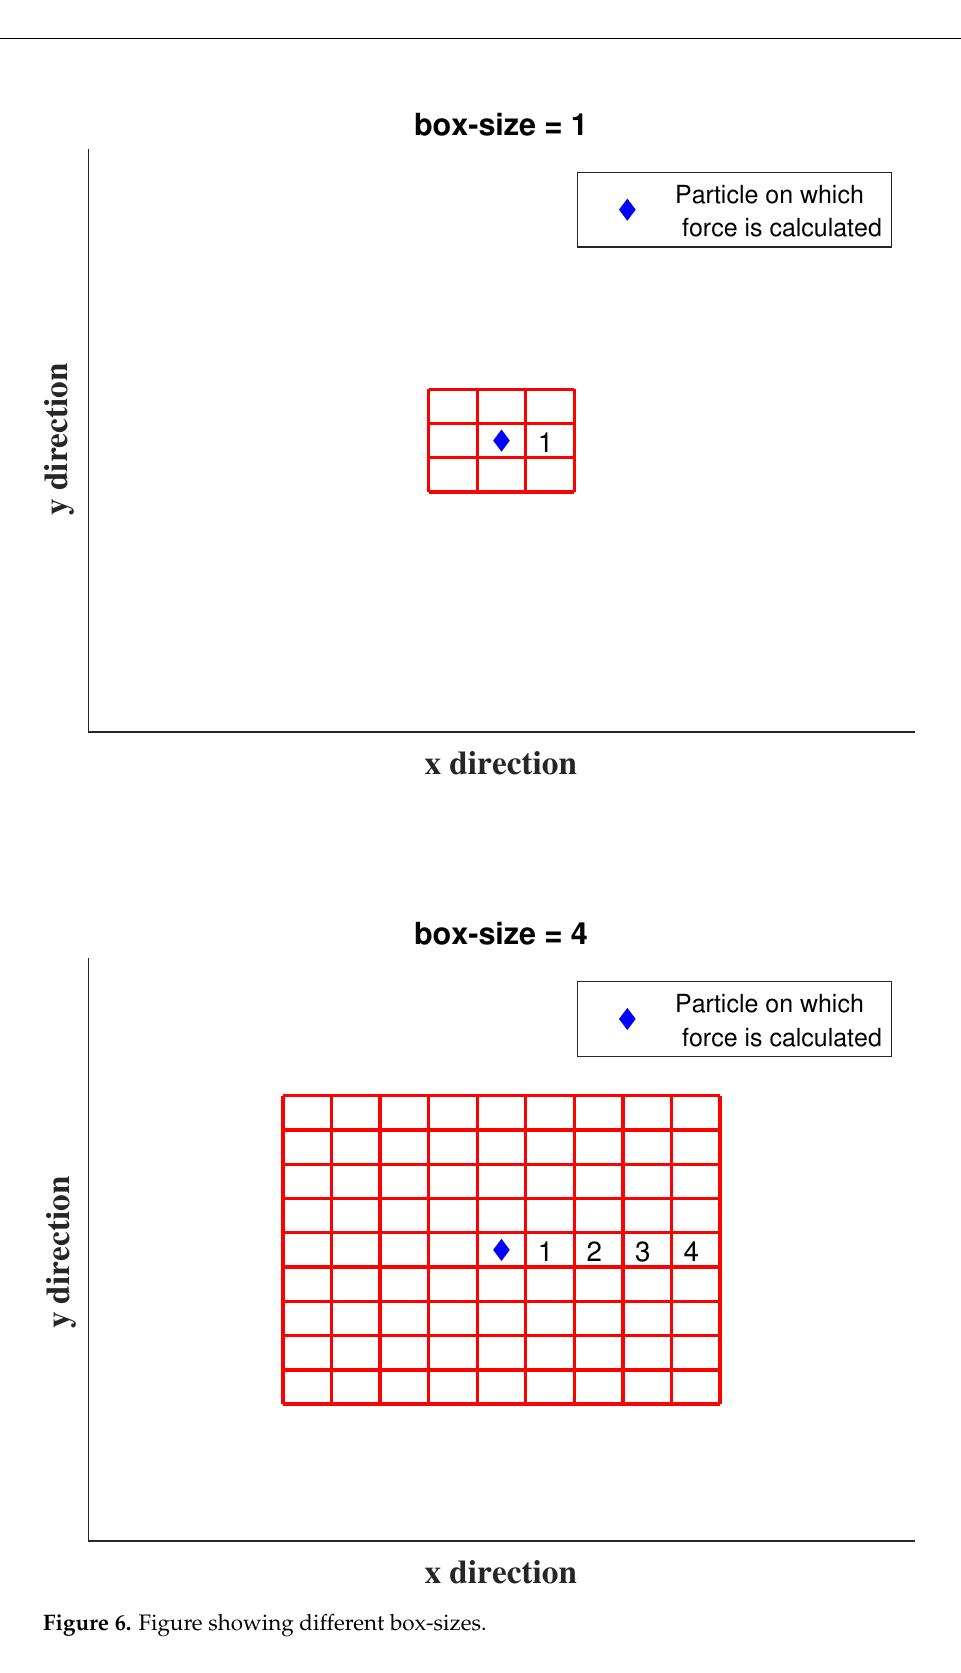
Figure 6. Figure showing different